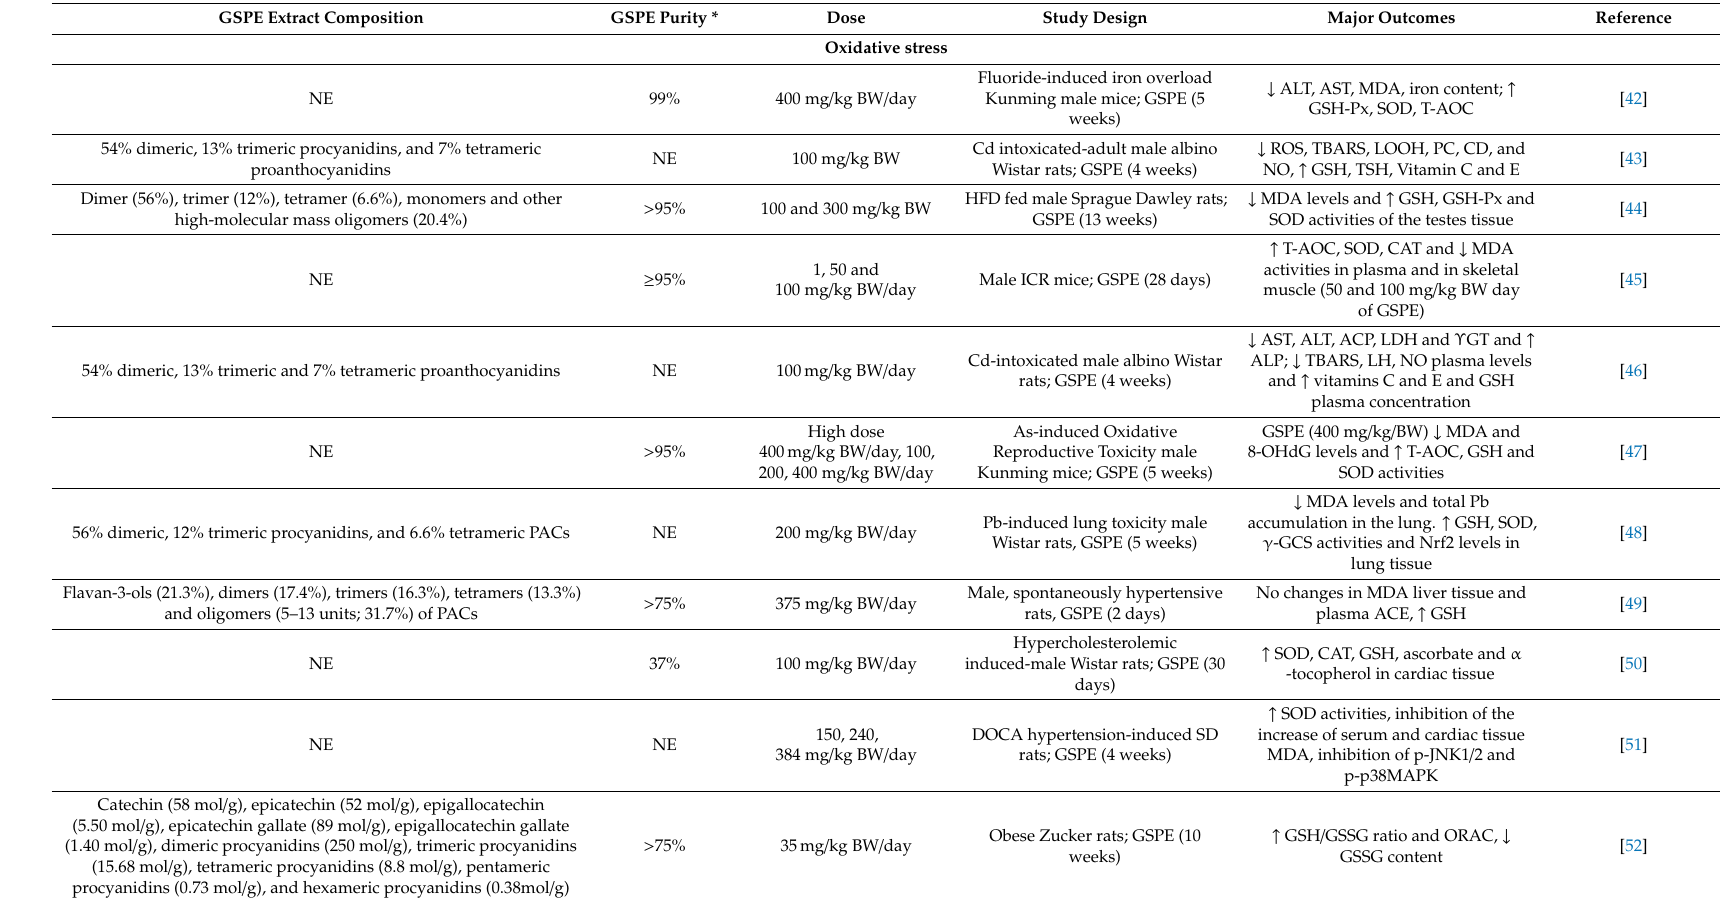
Table 1. E ff ect of proanthocyanidins from grape seeds on oxidative stress in animal